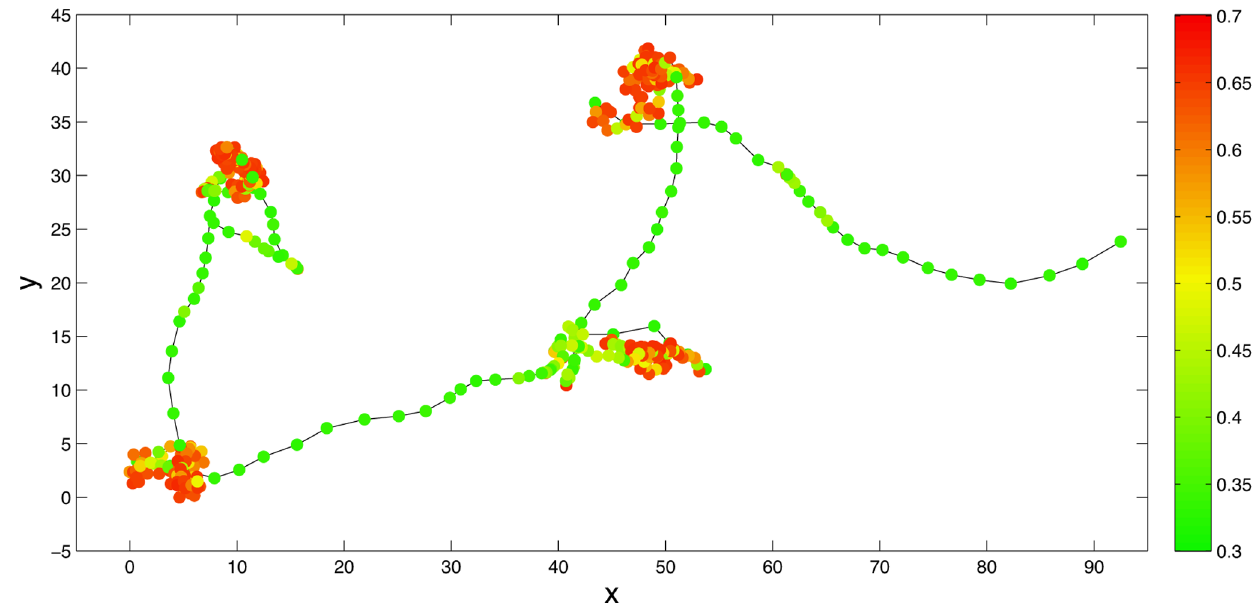
Figure 4. Synthetic data, at original frequency. Inferred behavioural states from the MCMC fitting are shown for each location (red is ‘slow-area- restricted’, green is ‘fast-directed’), and the colour scale indicates the posterior probability of each data point being in State 1.